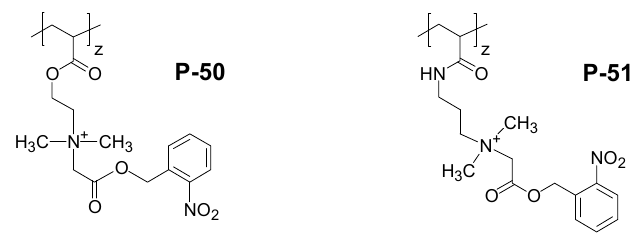
Figure 10. Examples for polycations that can be converted to polyzwitterions by photo-deprotection of the carboxylate group